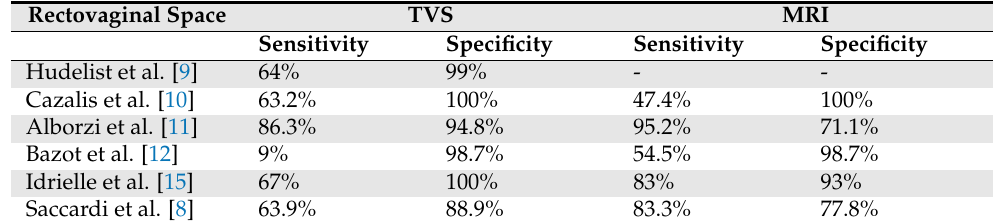
Table 4. The diagnostic accuracy of TVS and MRI in rectovaginal DE (as reported in different studies). Rectovaginal